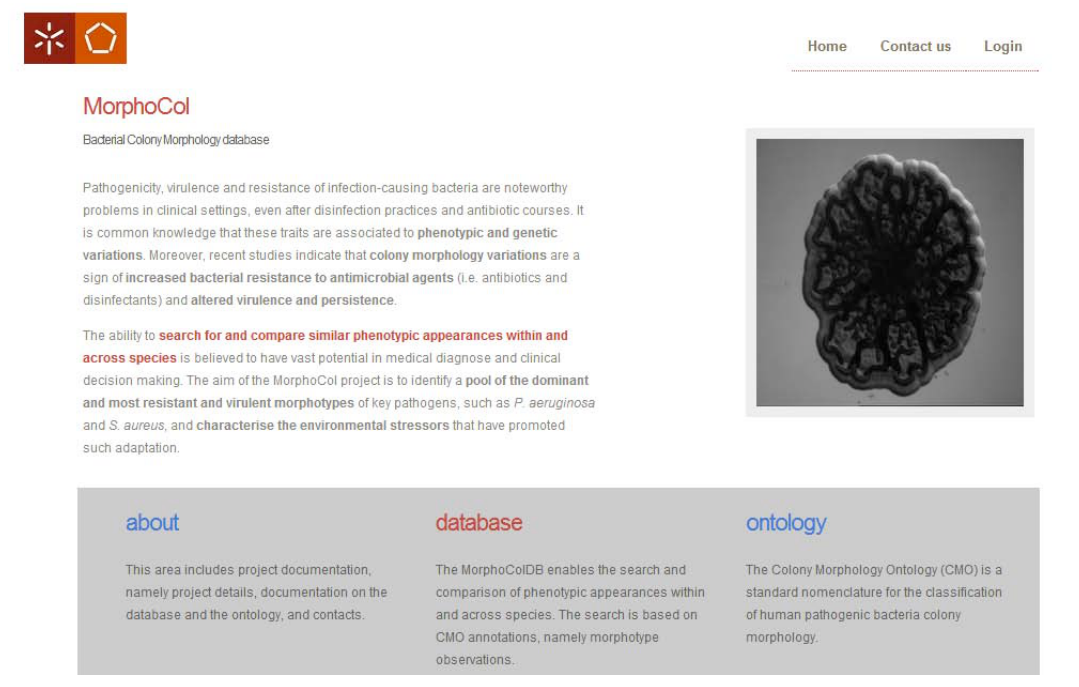
Fig. 6: MorphoCol site on colony